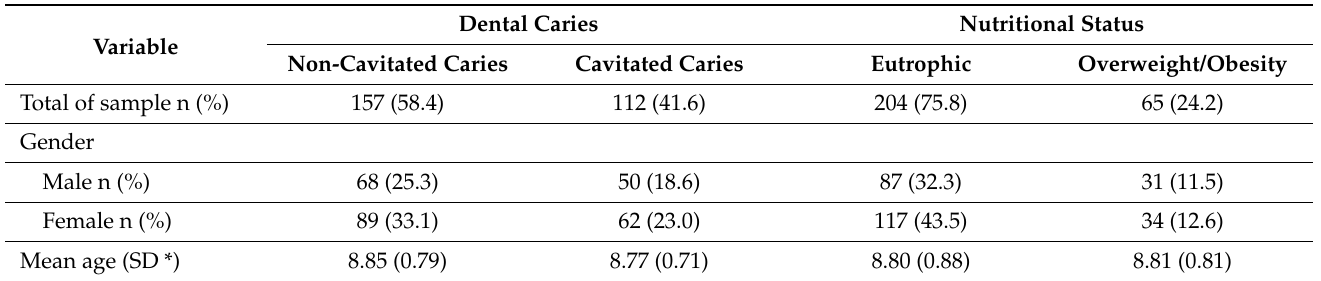
Table 1. Distribution of the characteristics according to the groups.